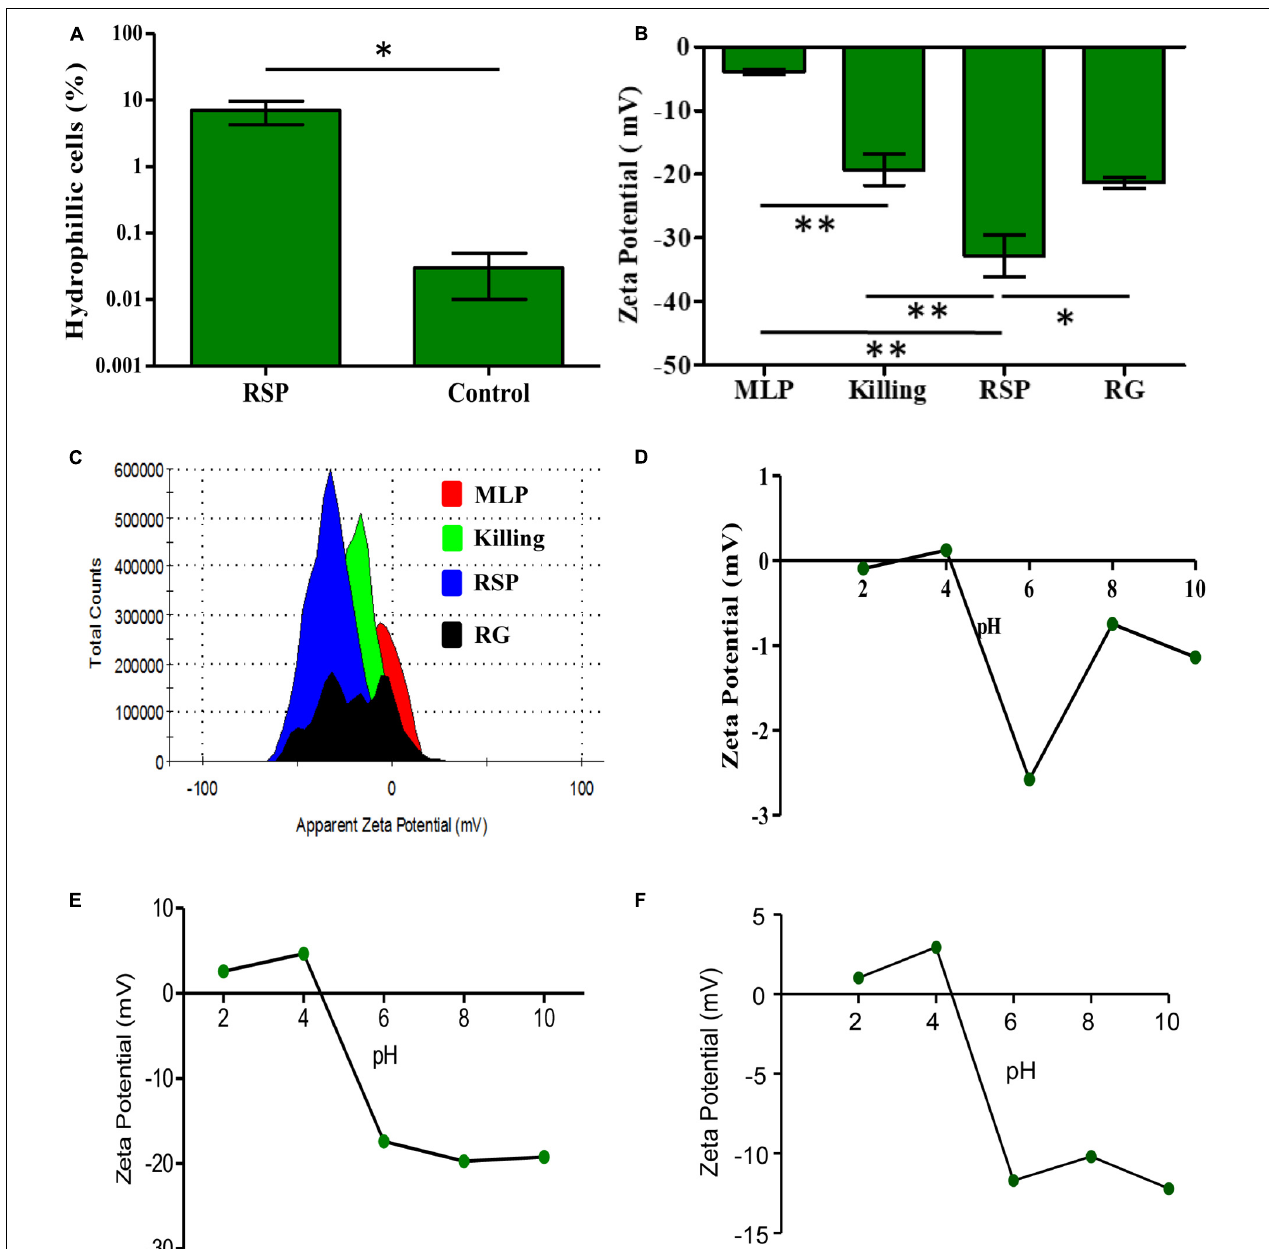
FIGURE 3 | Physicochemical properties of rifampicin-exposed M. tuberculosis cells from the rifampicin surviving population. (A) Hexadecane assay showing the proportions of hydrophilic cells of the rifampicin surviving population and MLP cells. (B) ZP of cells from different phases of rifampicin exposed of M. tuberculosis cells and its corresponding (C) histogram overlay. ZP of the cells as a function of pH showing the isoelectric point of the cells between pH 4.0 and pH 5.0 for: (D) MLP cells, (E) the cells of the rifampicin surviving population, and (F) cells from killing phase. One asterisk ( ∗ ) indicates P -value less than or equal to 0.05 ( P ≤ 0.05). Two asterisks ( ∗∗ ) indicate P -value less than or equal to 0.01 ( P ≤ 0.01). The statistical significance was calculated using two-tailed paired t